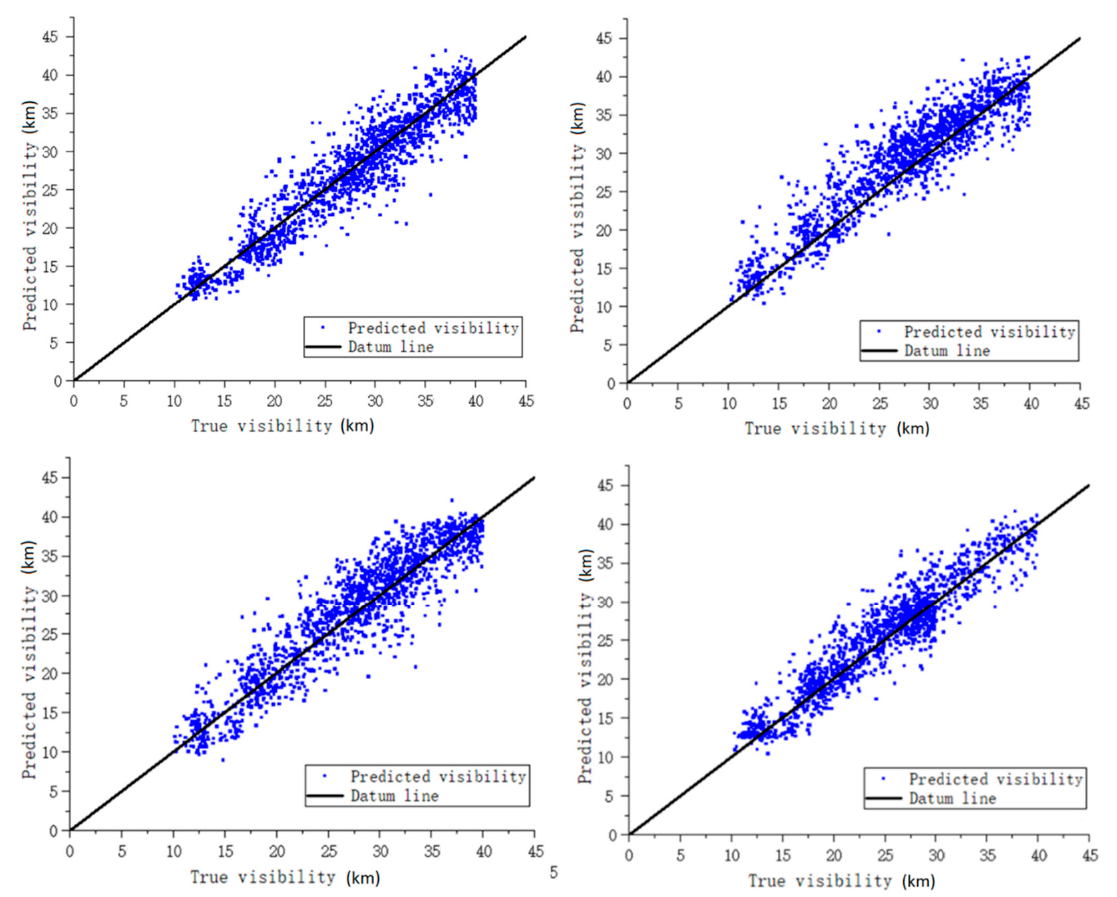
Figure 10. True and Predicted visibilities values by various ANN networks. Table 2. Experimental results of the proposed method by using different networks. (* refence data without PSO